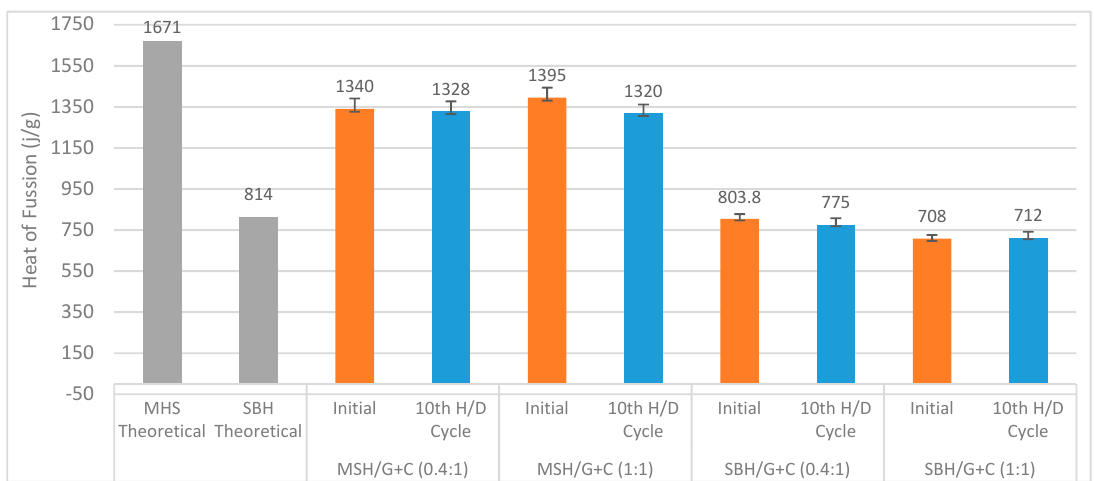
Figure 21. Heat of fusion of MSH / G + C (0.4:1) (1:1) and MSH / G + C (0.4:1) (1:1) pellets in comparison with the theoretical enthalpy of the fusion of the MSH and SBH from Table 1. The theoretical values show the heat of fusion values of the transitions for 7 and 5 moles of water release from MSH and SBH, respectively. Experimental values show the heat of fusion values corresponding to the near complete dehydration of the composite pellets.